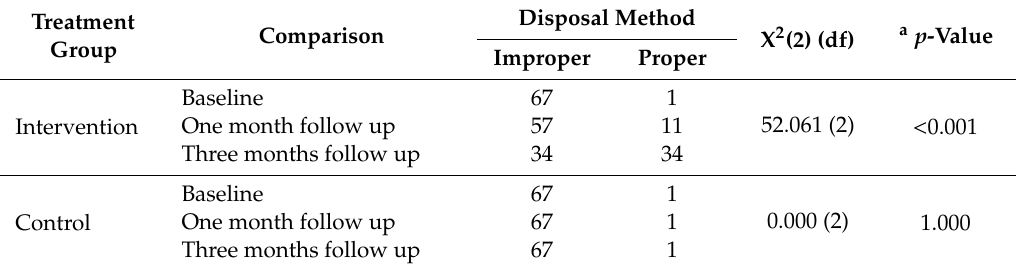
Table 5. Comparison in proportion of proper community sharp disposal method over time in intervention and control group, using ITT approach ( n =